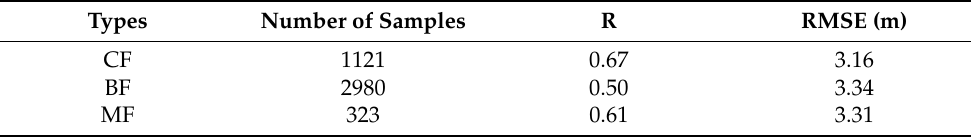
Table 5. The calculated R and RMSE for RH95 metric of sample and predicted results for Area 2.